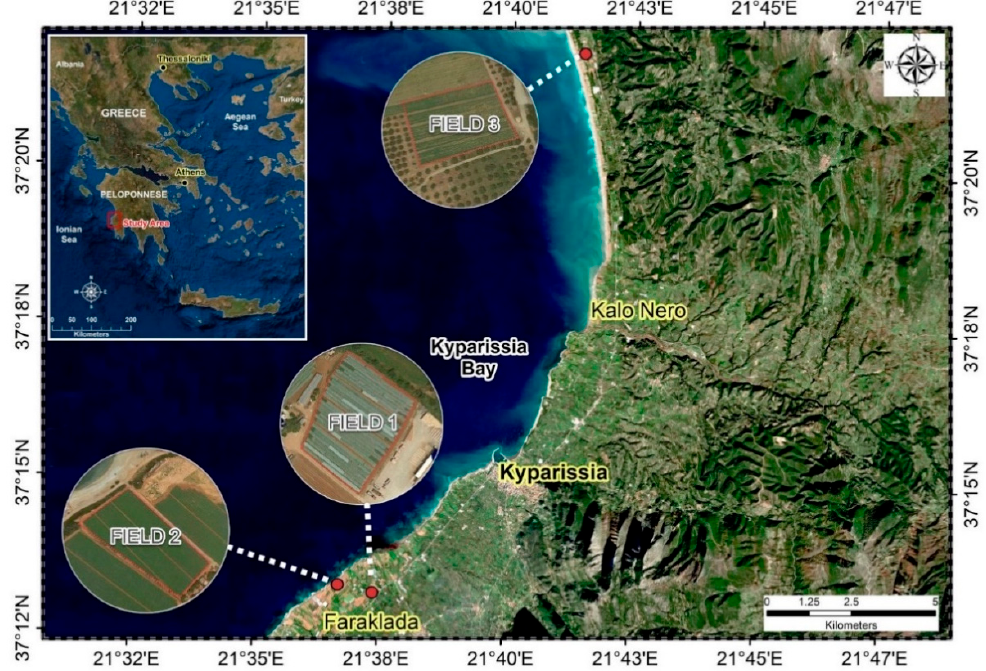
Figure 3. Location of the GWD project’s experimental fields in Trifilia.